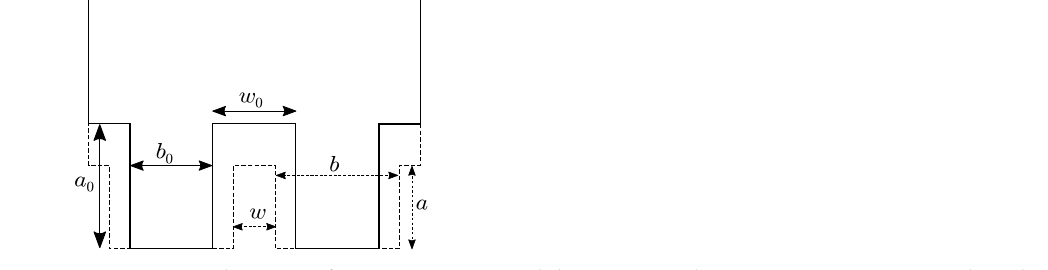
Figure 4. Development of intimate contact and the corresponding geometric parameters, based on the theory of [31].